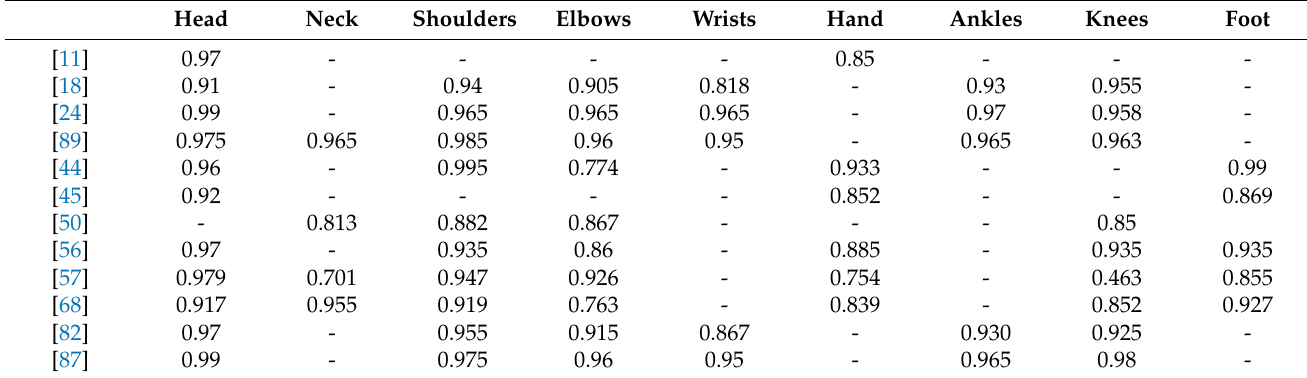
Table 3. Tracking accuracy of the human body joints in the referenced works. Head